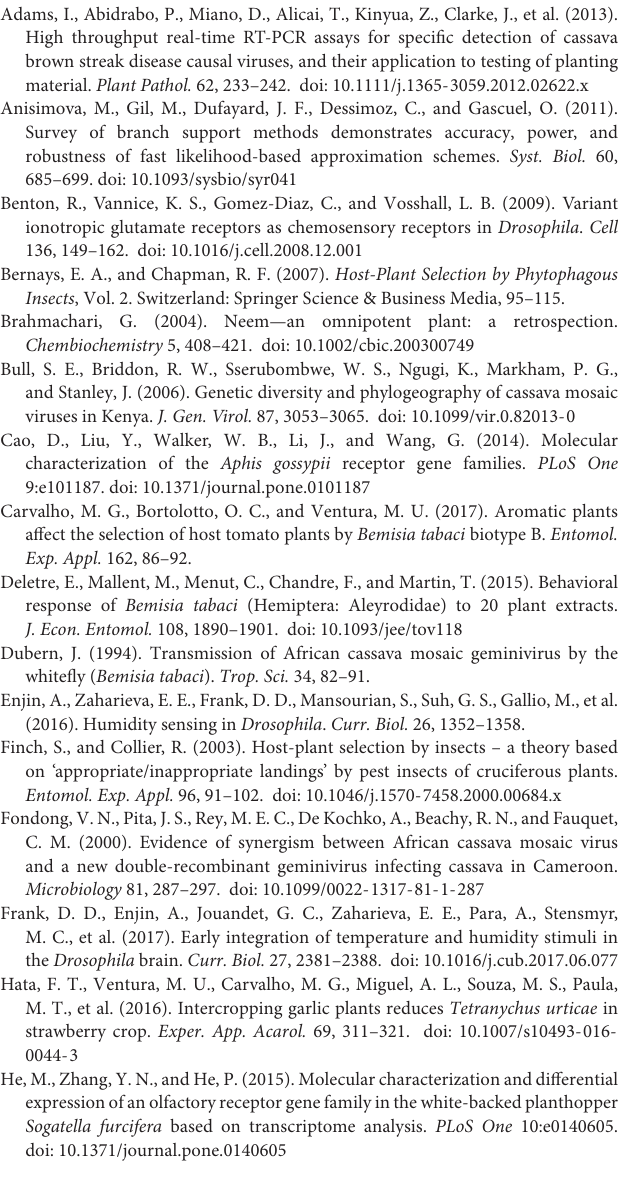
primer sequence pairs and their melting temperatures, for each of the Or